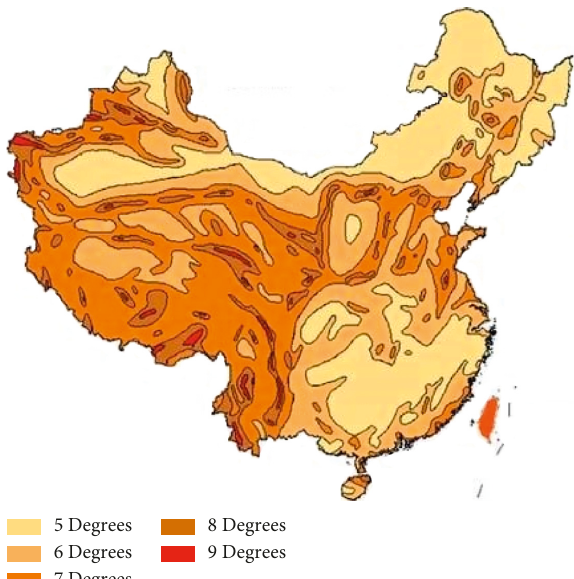
Figure 1: Earthquake intensity zoning map of China.